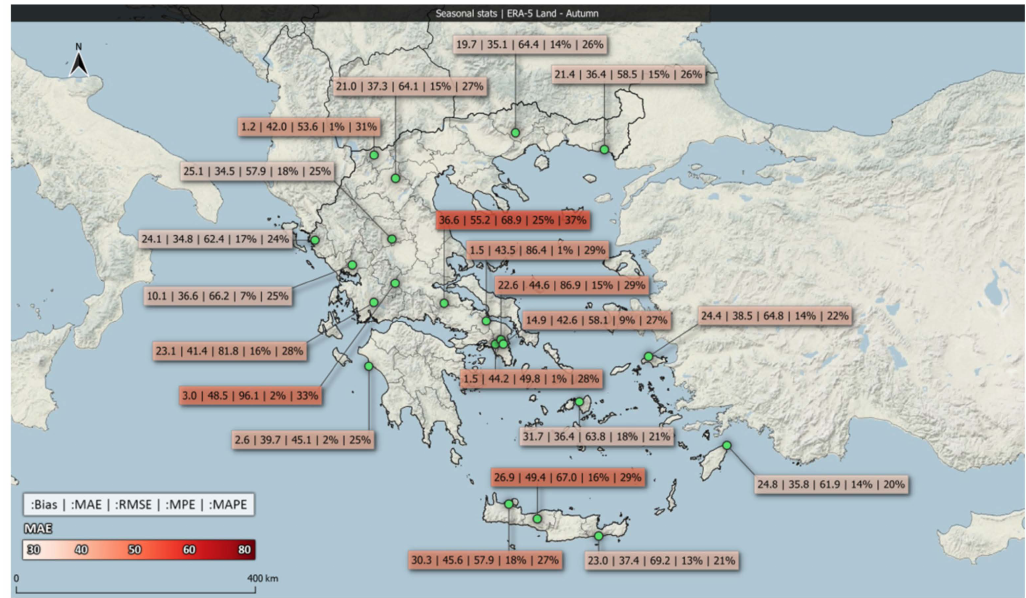
Figure 6. Bias (W/m 2 ), MAE (W/m 2 ), RMSE (W/m 2 ), and MPE and MAPE (both ranging from 0 to 1 for better visualization) between ERA5-Land and surface observations for autumn (SON) in the Greek